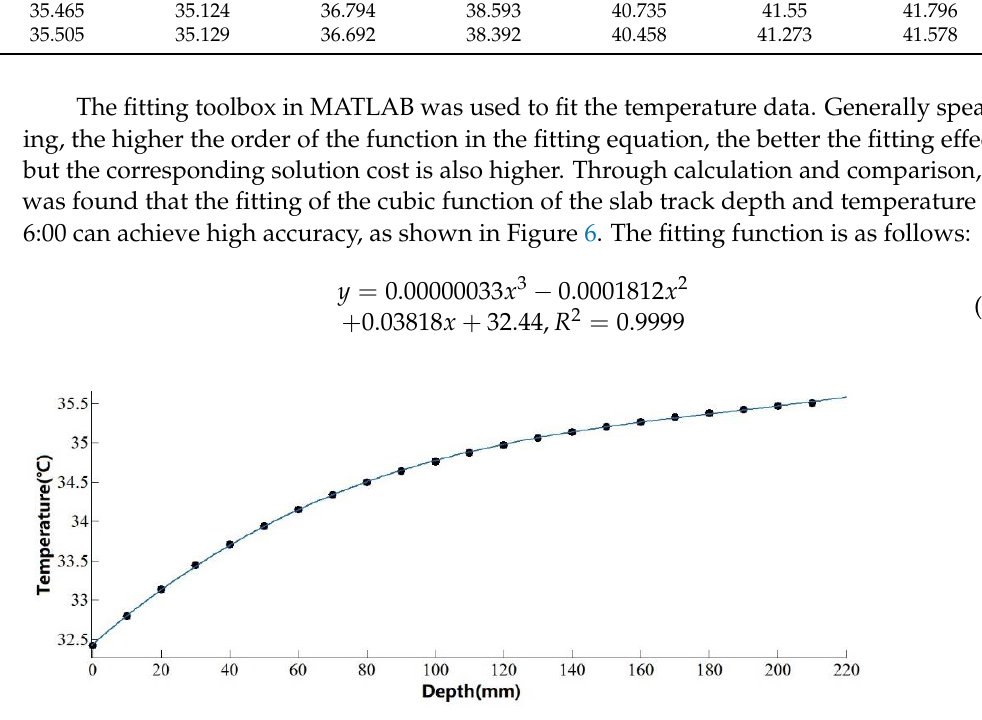
Figure 6. The cubic function fitting results of the relationship between the slab track depth and the temperature at 6:00.